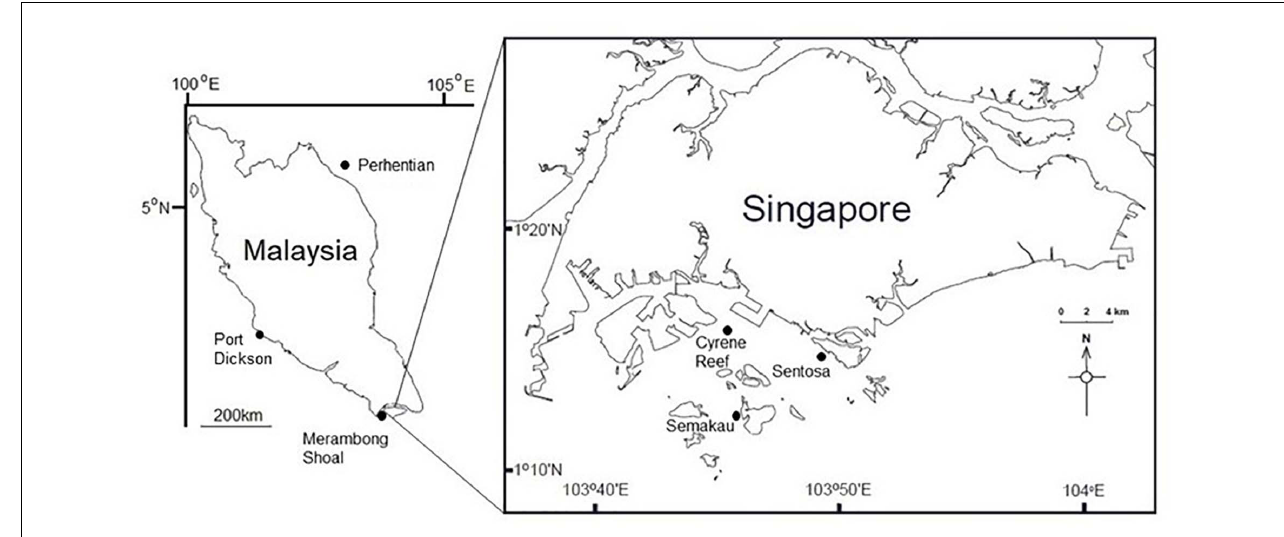
FIGURE 1 | Location of sampling sites throughout Singapore and Peninsular